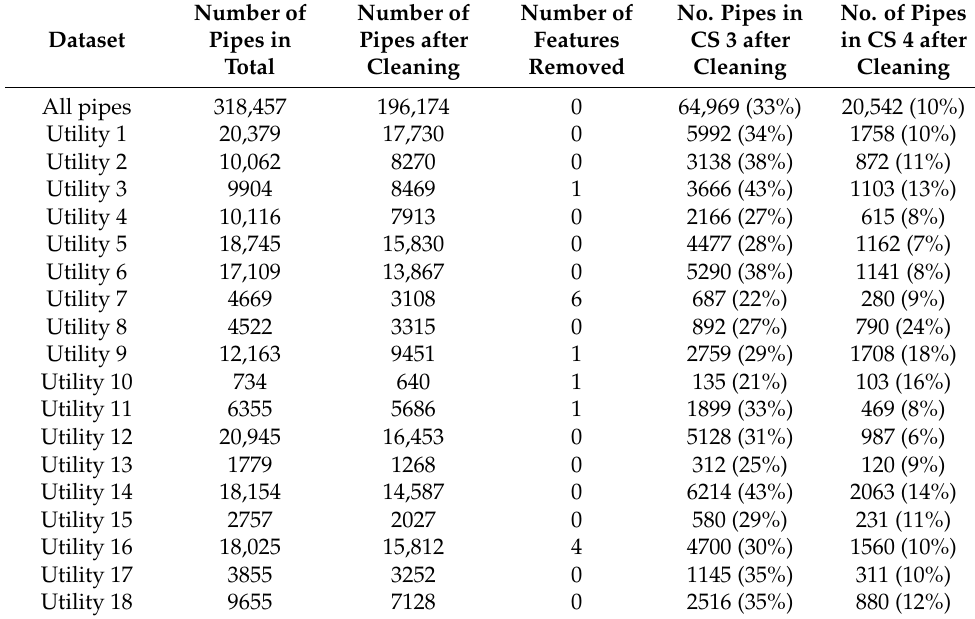
Table 3. Overview of the datasets containing more than 100 bad pipes before and after cleaning, as well as the number of features removed in the cleaning process and the number of pipes in condition state (CS) three and four after